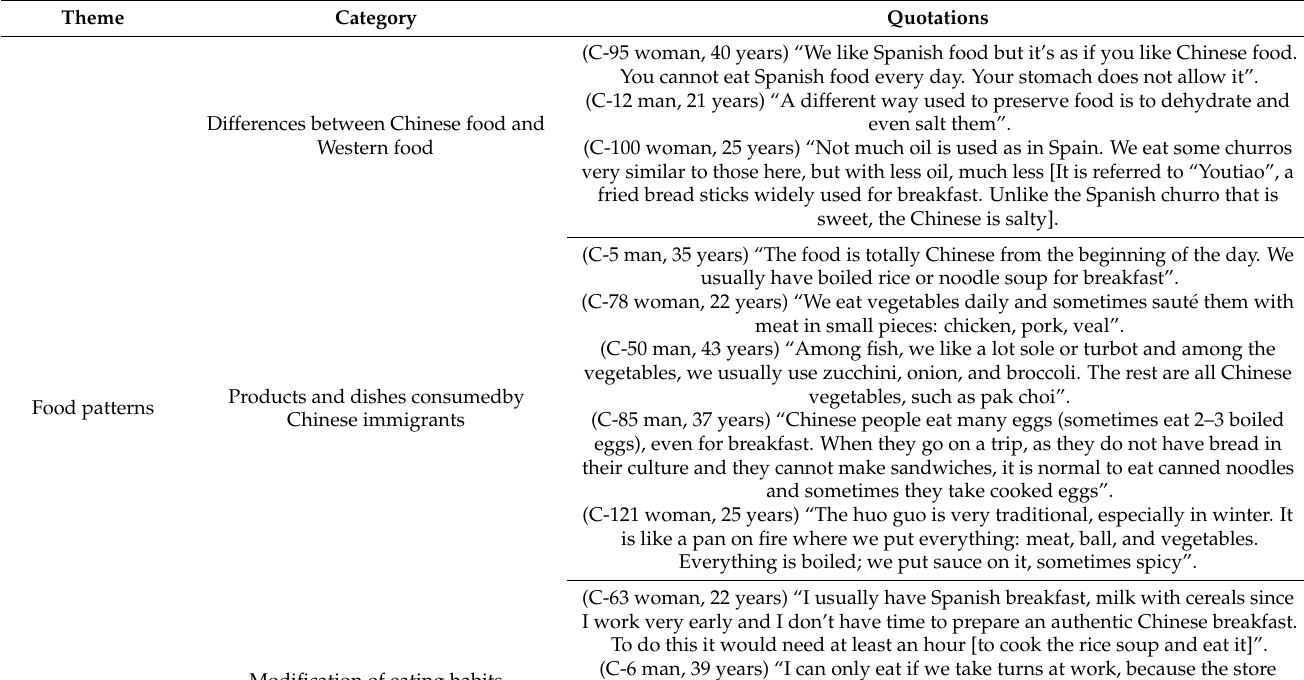
Triangle shaped dumplings filled as white rice or yellow rice (a form of millet), Zongzi served dotted with sweetened dates. In Zhejiang province, Jiaxing zongzi is stuffed with marinated ham and wrapped with a leaf. It is a dish of Chinese–American origin that literally means "mixed pieces." It usually consists of meats (chicken, beef, shrimp, or pork), cooked in a wok with Chop suey vegetables such as celery, peppers, green beans, among others. It is served with steamed white rice. T¯angyu á n are sweet glutinous rice balls, sugar, and almonds. The Chinese New Year celebration ends on the fifteenth lunar day (yu á n xi¯ao ji é ), known worldwide as the Lantern Festival. Some traditions of this day are to appreciate colorful T¯angyu á n lanterns through the streets and eat with the family the sweet soup of t¯angyu á n. Having a round and compact shape, it symbolizes the strong family union. It is also consumed as a dessert at Chinese weddings, and at the Winter Solstice Festival (D¯ongzh ì ). Qingmingguo is a traditional snack eaten on China Tomb Sweeping Day, also known as the Qingming Festival. It is mainly made up of Gnaphalium affine or Qingmingguo Jersey Cudweed, a kind of medicinal plant mixed with glutinated rice flour, normally filled with pork, mushrooms, carrots, douya, doufu, and others. Moon cakes (yuebing) are traditional snacks eaten during the Zhongqiujie or Mid-Autumn Festival, the second largest festival in China. They are filled with Yuebing soybean red bean paste, lotus seeds with a salted duck egg or nuts. Its roundness represents family reunion, that is, complete happiness and